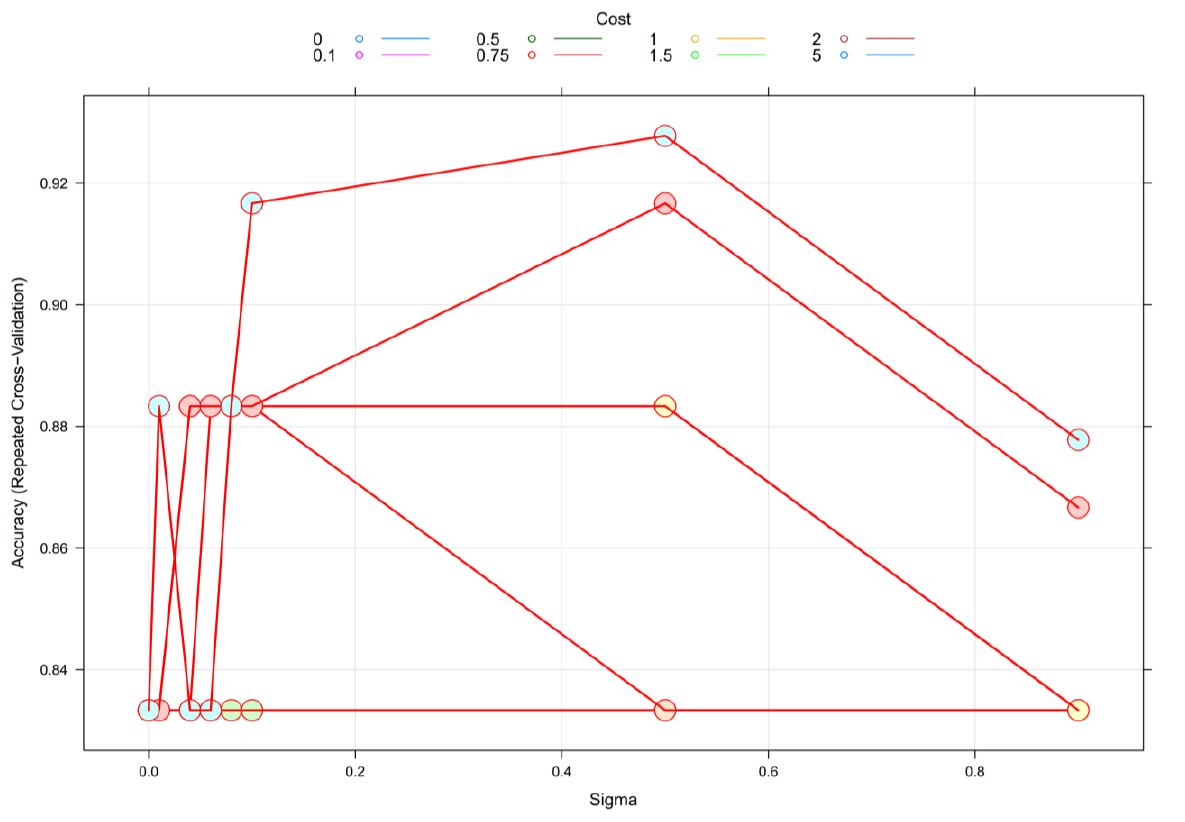
Figure 5. SVM RBF